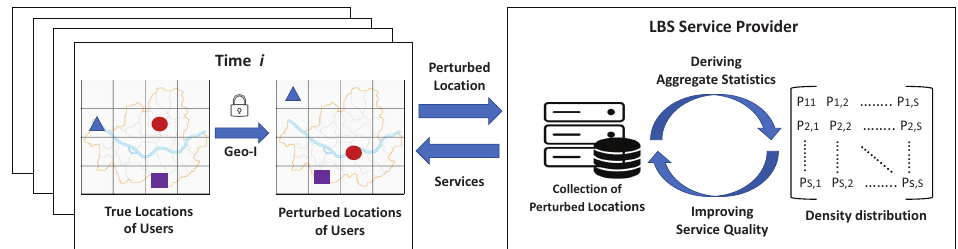
Figure 1. High level architecture of the proposed